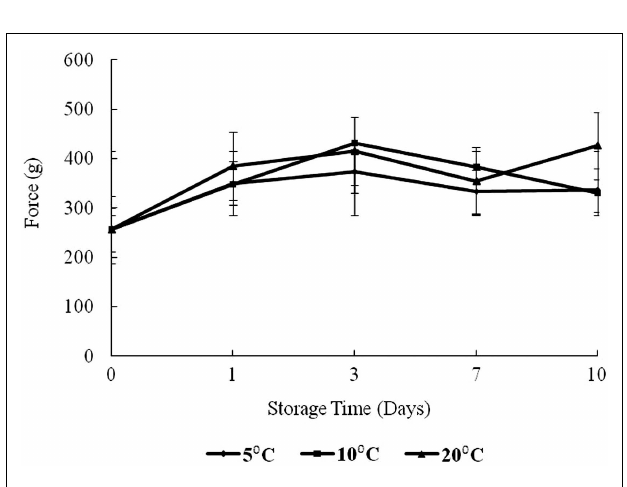
FIGURE 7 | Changes in force versus storage time (days) and temperature (5, 10, and 20°C) .